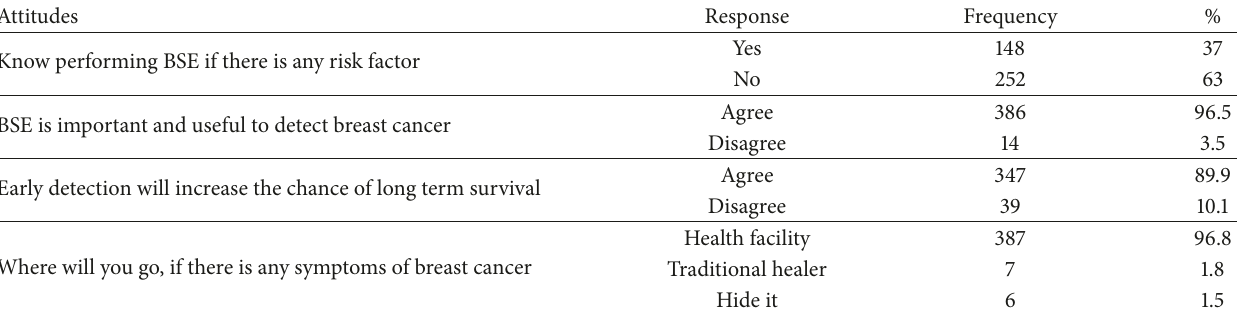
Table 3: Attitude about BSE among female DBU